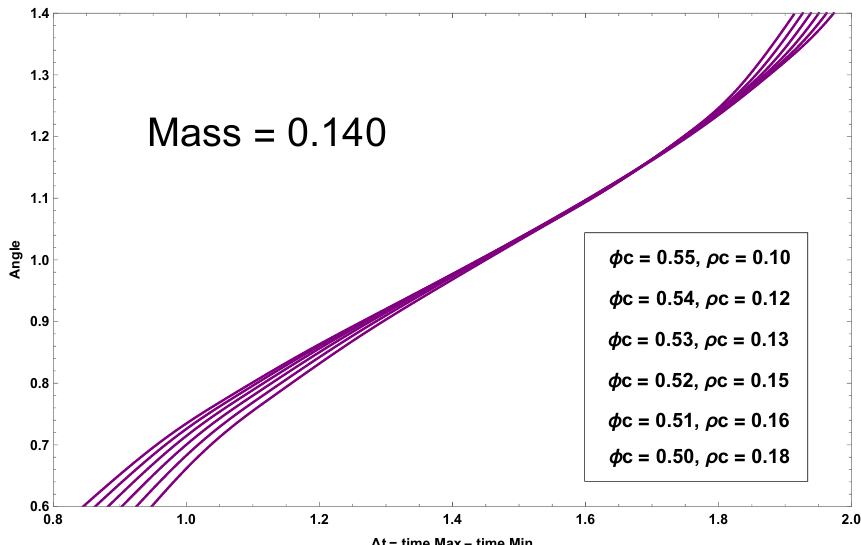
Figure 3. Plot of the angle (cid:12) vs (cid:1) t for solutions with di(cid:11)erent values of (cid:26) c and (cid:30) c , and total mass M Total = 0 :